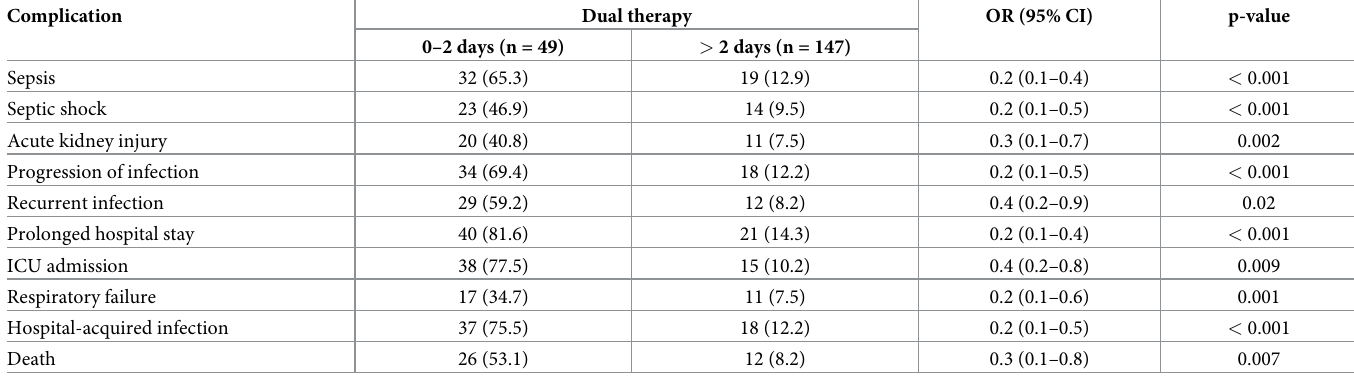
Table 3. Clinical complications reported in patients who received dual antipseudomonal therapy compared to those reported in patients who received monotherapy.